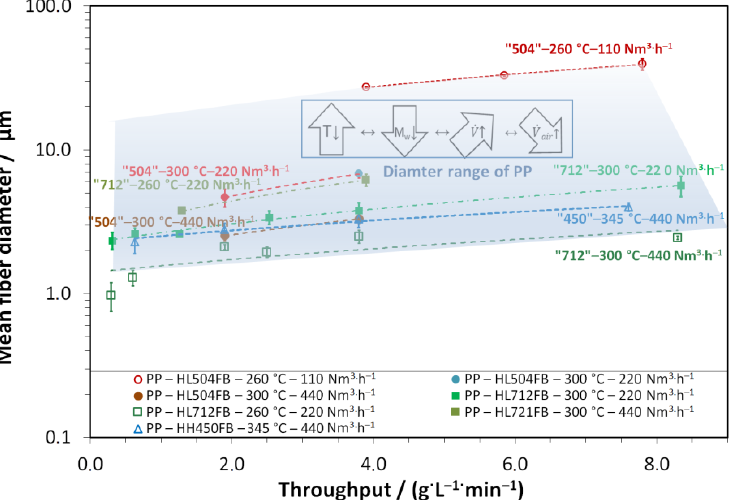
Figure 6. Process map of polypropylene for achievable fiber diameters as a function of the polymer throughput under variation of the PP-type, polymer, and air throughput (DCD, DDAC, and collec- tor are kept constant); the lines represent linear fits. are kept constant); the lines represent linear